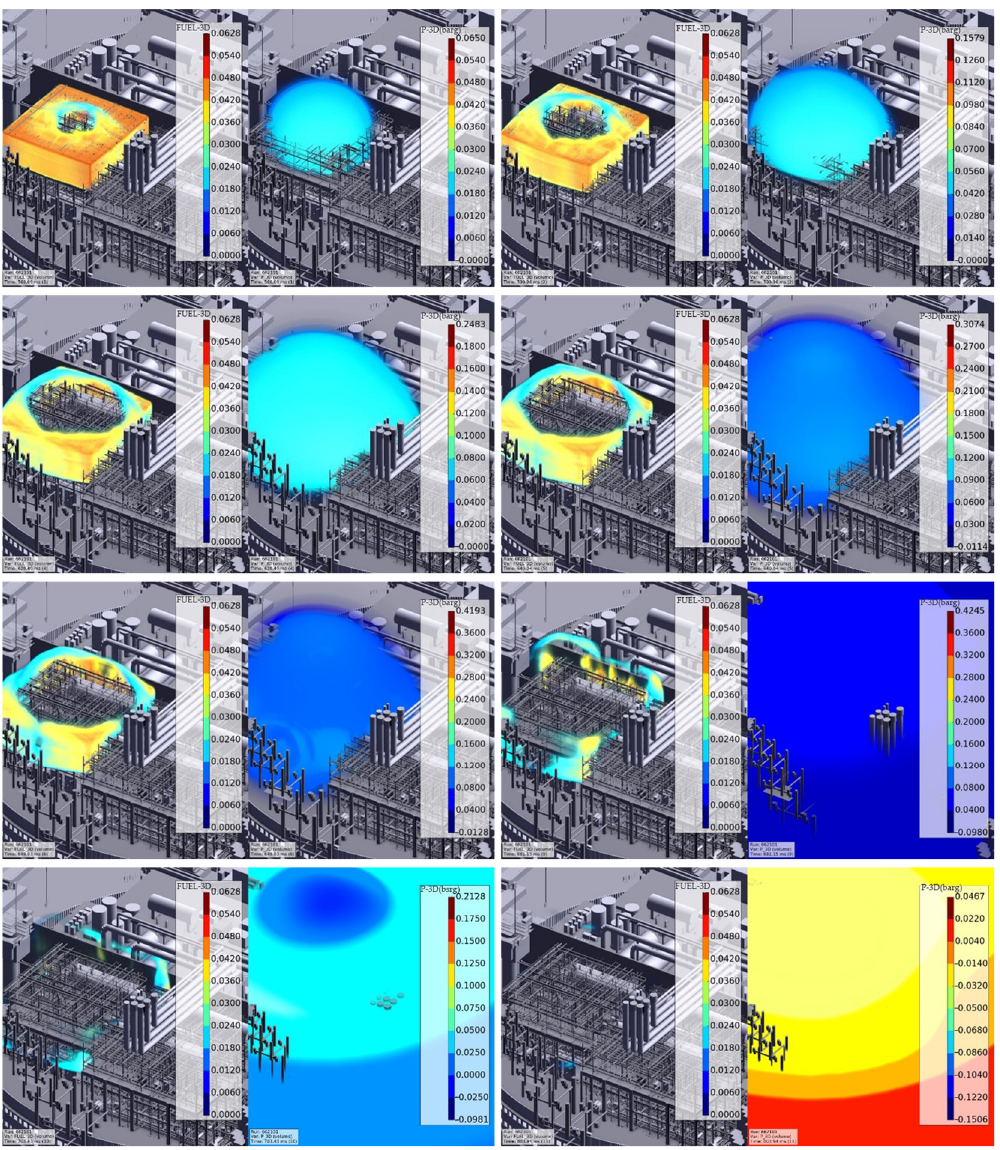
Figure 12. Highest overpressure (barg) time history plot (case 662,101) in a 3D view. Time is increasing from top left to bottom right. The figure on the left shows the gas cloud and that on the right shows the overpressure wave.